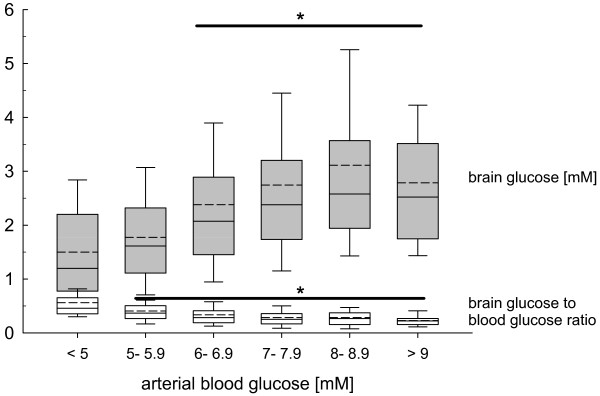
Changes in brain glucose determined by microdialysis (grey box plots) and calculated brain-to-blood glucose ratio (white box plots) in pre-defined blood glucose clusters, ranging from less than 5 mM to more than 9 mM in 1 mM buckets. At arterial blood glucose levels exceeding 6 mM brain glucose was significantly increased. With increasing arterial blood glucose and brain glucose levels calculated brain-to-blood glucose ratio was significantly decreased, reflecting reduced cerebral uptake. Increases across the pre-defined blood glucose clusters compared with low arterial blood glucose levels were significant (*P < 0.001; analysis of variance on ranks, post hoc Dunn's test).